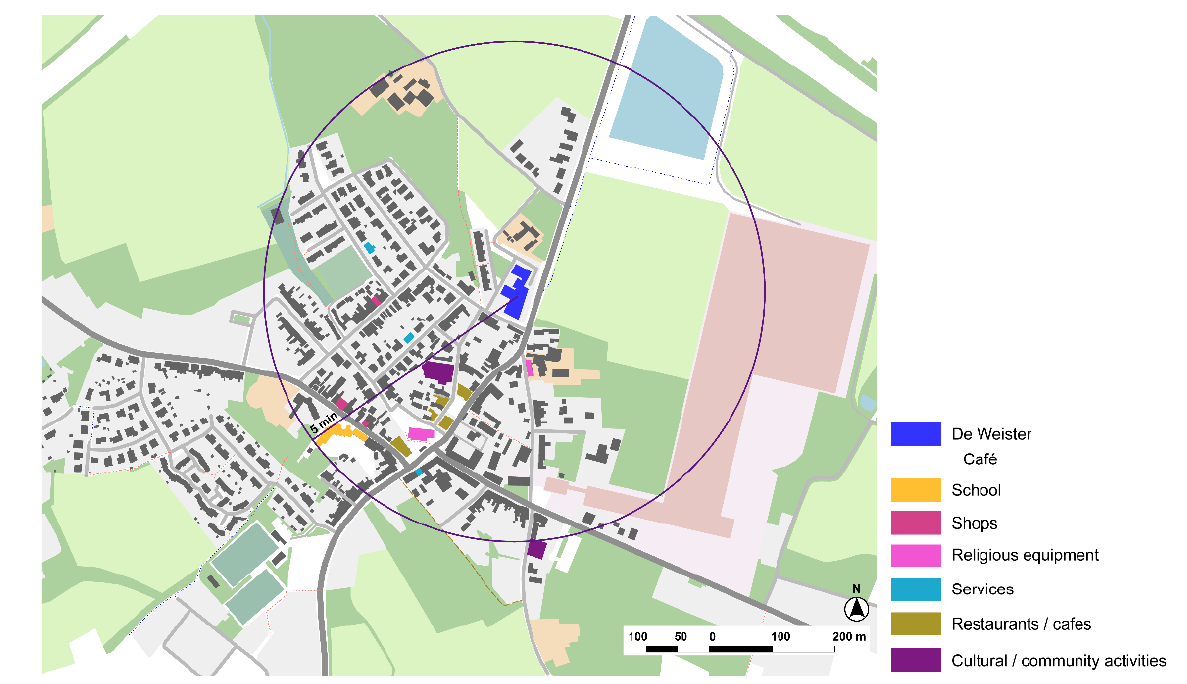
Figure 11. De Weister’s location in Aalbeke, Kortrijk, Belgium. Source: Own elaboration.